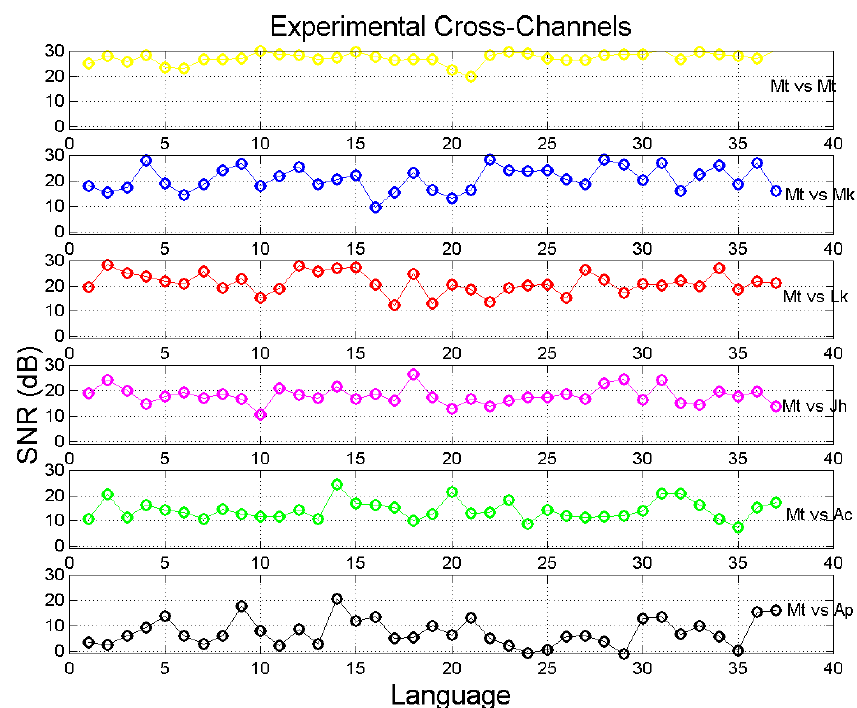
Figure 8. Experimental signal ‐ to ‐ noise ‐ ratio Γ (cid:3031)(cid:3003),(cid:3032)(cid:3051)(cid:3047) in Matthew self ‐ channel and in its cross ‐ chan ‐ nels in the indicated languages. Languages are ordered according to Table 1. Color key : yellow = Mt vs. Mt; blue = Mt vs. Mk; red = Mt vs. Lk; magenta = Mt vs. Jh; green = Mt vs. Ac; black = Mt vs. Ap.